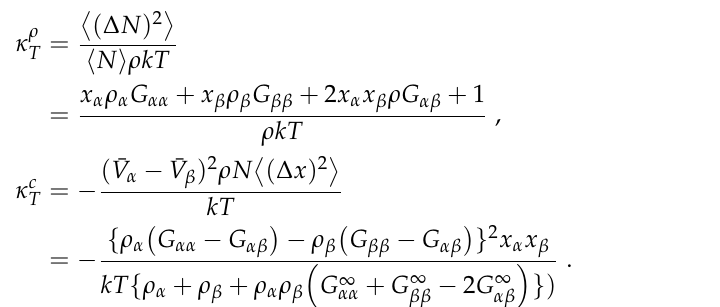
Figure 14. The two terms contributing to the isothermal compressibility κ T = κ ρ T = 85K as a function of inverse system size 1/ L . ( a ) Density fluctuation term κ ρ ( b ) Concentration fluctuation term κ c (i.e., at maximum L